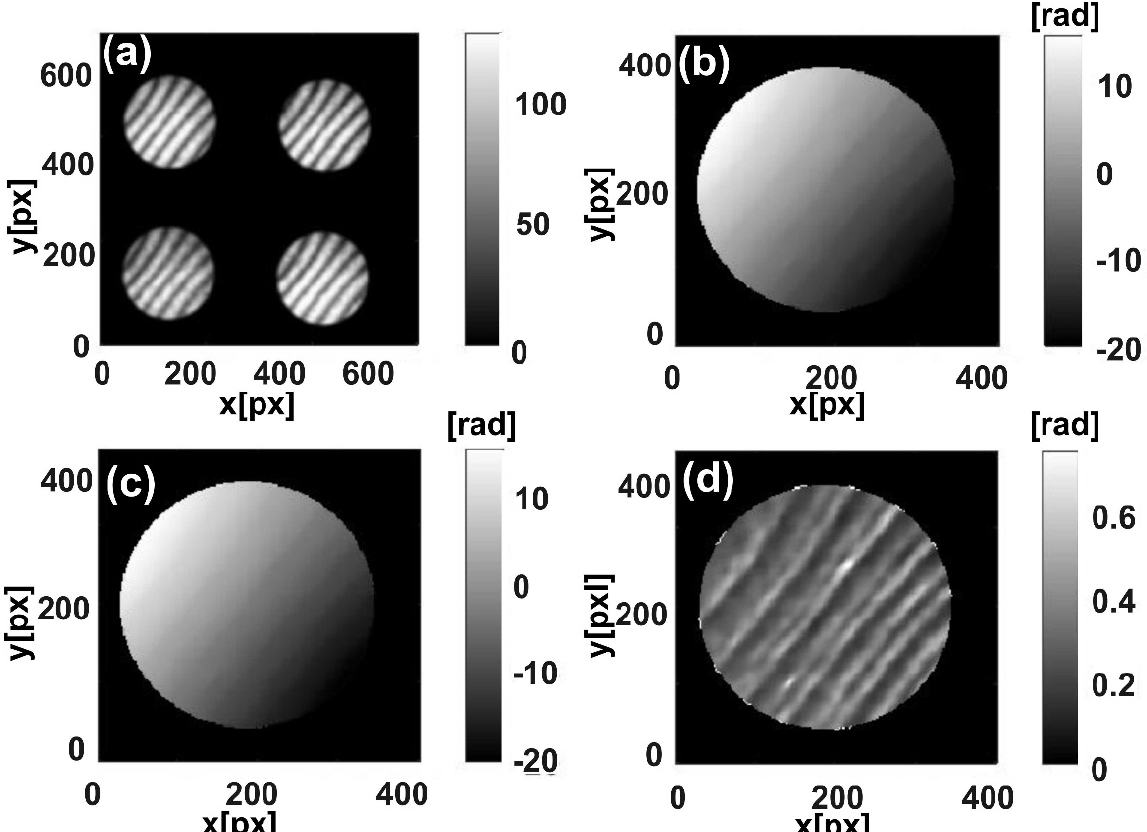
Figure 11. Stability of the system. ( a ) Intensity: Four phase-shifted interferograms. ( b ) Unwrapped phase for the first frame. ( c ) Mean. ( d ) Standard deviation.